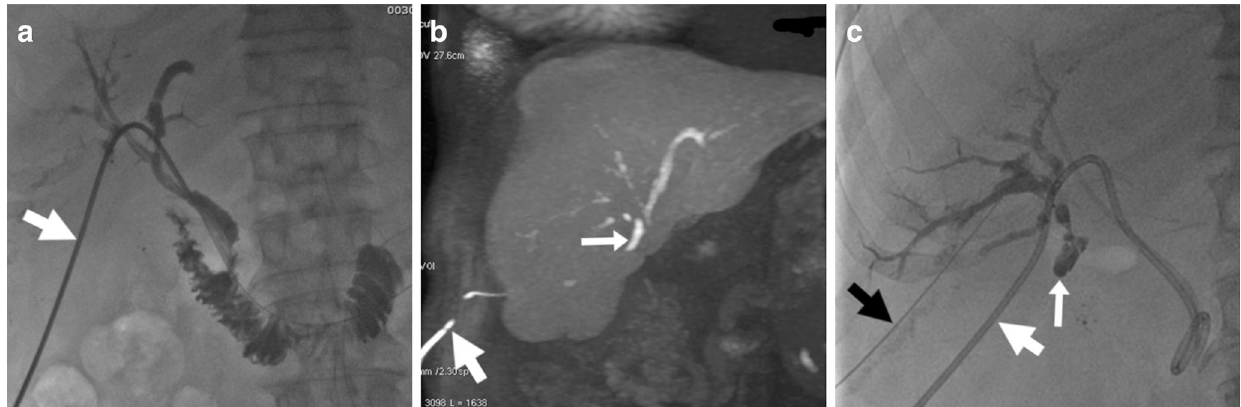
Fig. 20 After recent elective laparoscopic cholecystectomy, low-output bile loss from drainage and small-sized biloma in the gallbladder fossa (not shown) persisted despite percutaneous treatment with the positioning of a plug and absent biliary leakage at cholangiography ( a ) from percu- taneous transhepatic biliary drainage (PTBD) ( thick arrow ). Gadoxetic acid-enhanced MRCP ( b , coronal MIP reconstructed image) showed